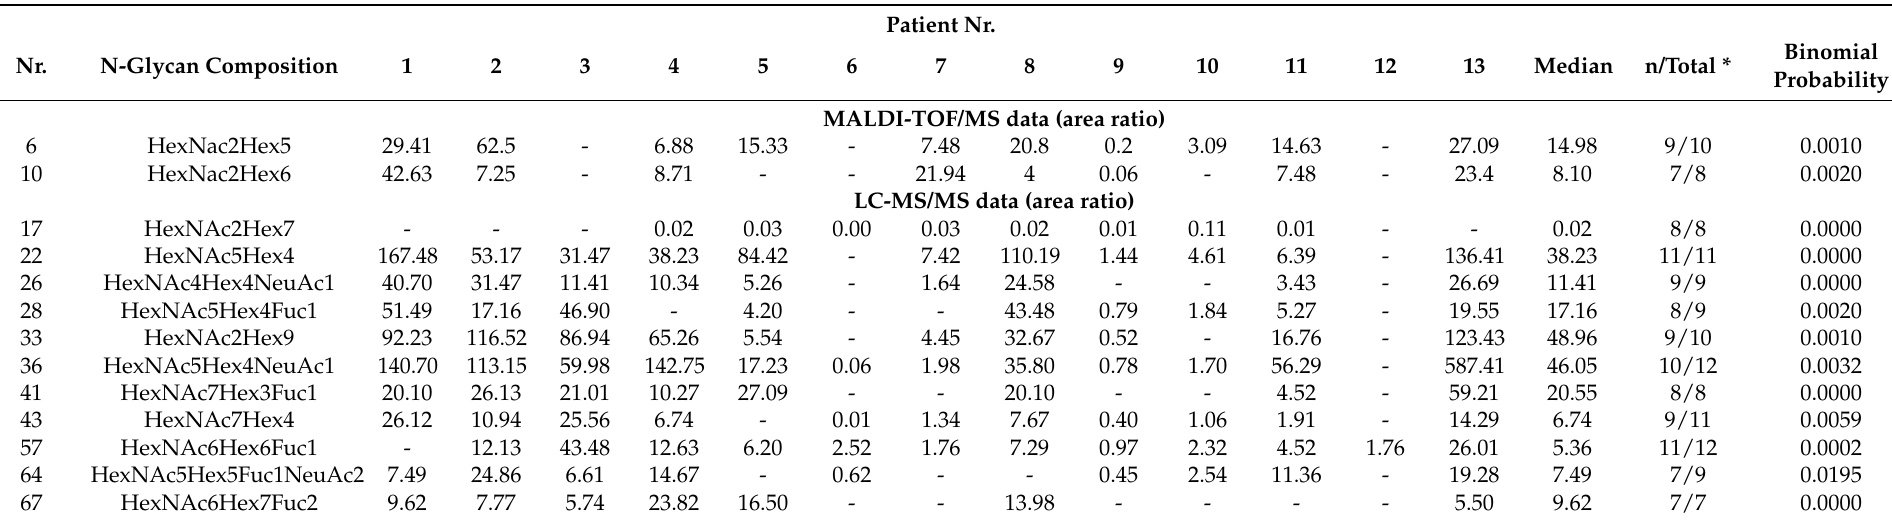
Table 4. Relative concentration of N-glycans in samples of tumor and normal tissues from all cancer patients obtained by MALDI-TOF/MS and LC-MS/MS. Patient